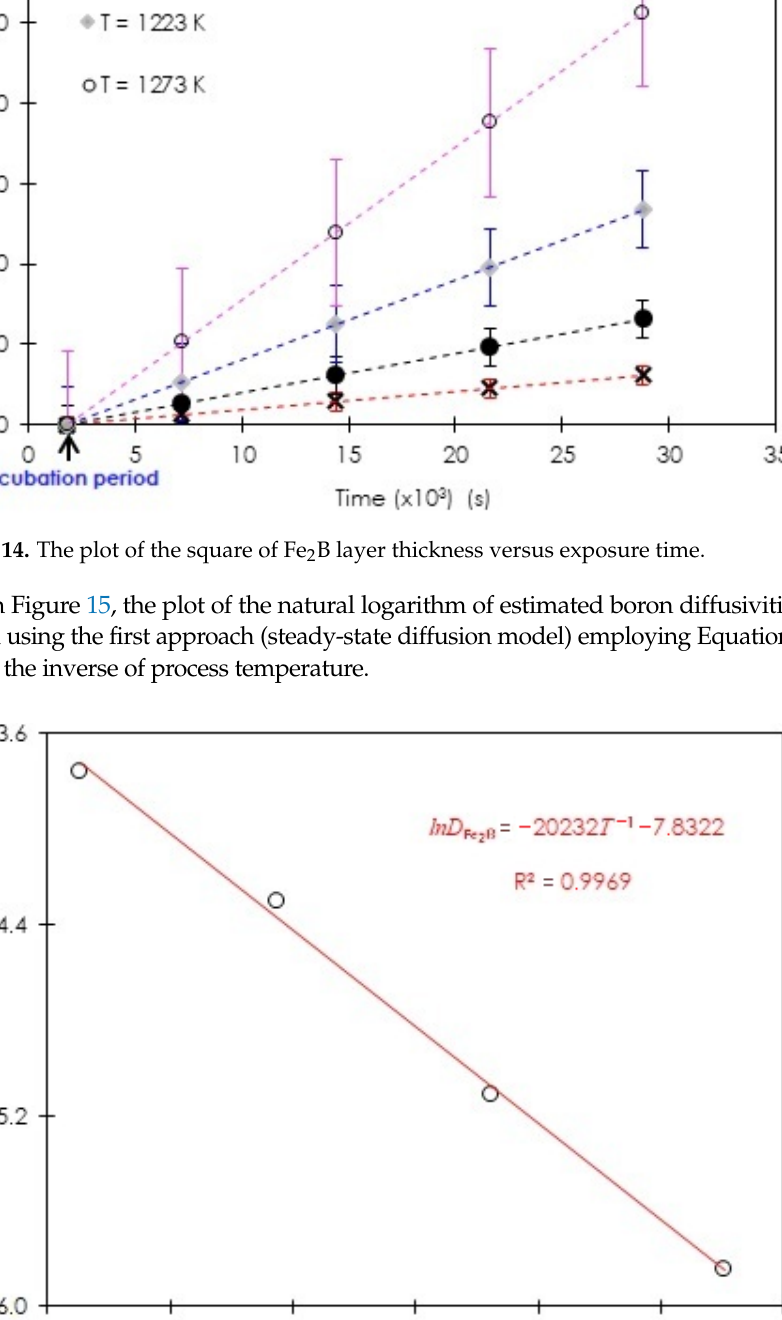
Figure 15. Arrhenius relationship between the estimated boron diffusivity in Fe 2 B and the process temperature by the first approach (steady-state diffusion model).